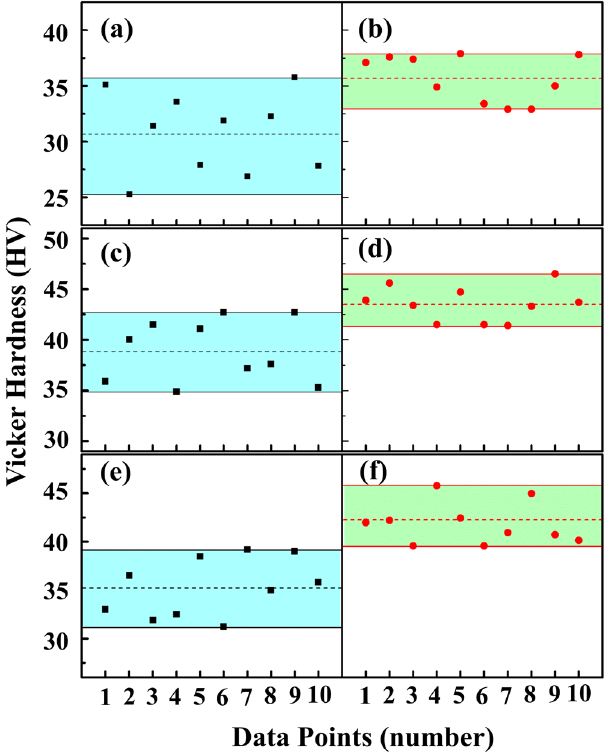
Figure 8. Vicker Hardness of all samples. The loading force and loading time are 0.245 N and 10 s, respectively. ( a ) Bi 2 Te 2.7 Se 0.3 -A; ( b ) Bi 2 Te 2.7 Se 0.3 -B; ( c ) Bi 2 Te 2.55 Se 0.45 -A; ( d ) Bi 2 Te 2.55 Se 0.45 -B; ( e ) Bi 2 Te 2.4 Se 0.6 -A; ( f ) Bi 2 Te 2.4 Se 0.6